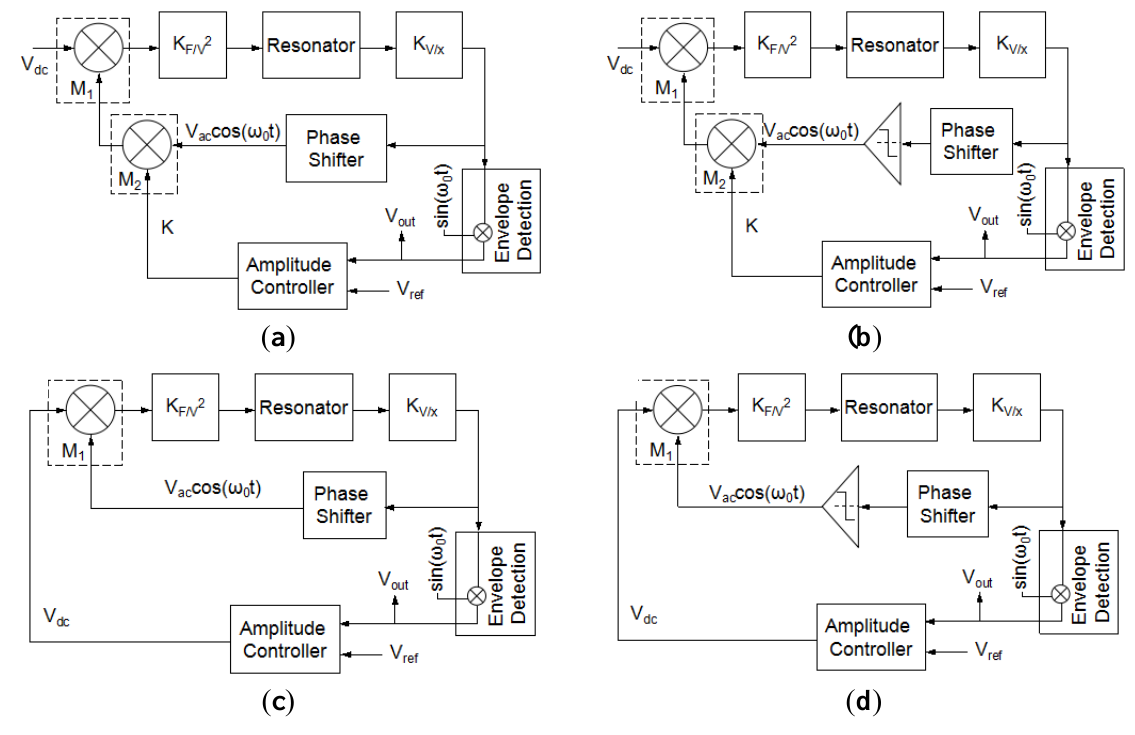
Figure 28. Different kinds of AGCs. ( a ) AC sine wave control. ( b ) AC square wave control. ( c ) DC sine wave control. ( d ) DC square wave